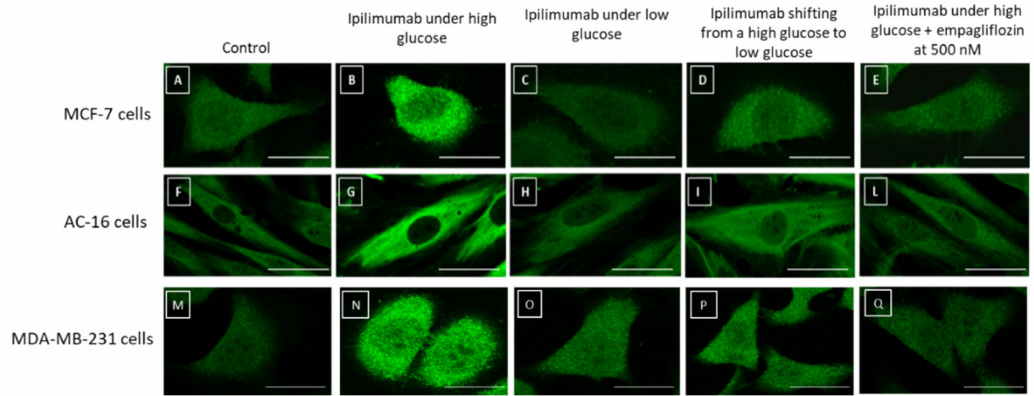
Figure 7. NLRP3 straining (green signals) in MCF-7 ( A – E ), AC-16 ( F – I , L ), and MDA-MB-231 cells ( M – Q ) treated with ipilimumab under high glucose ( B , G , N ); low glucose ( C , H , O ); shifting from a high glucose to low glucose ( D , I , P ), and high glucose + empagliflozin at 500 nM ( E , L , Q ). Untreated cells with an unrelated control IgG (control) were used as negative controls ( A , F , M ). Scale bar: 50 µ m. 2.8. Pro-Inflamamtory Cytokines and Growth Factors Are Overexpressed during Hyperglycemia NLRP3 and MyD88 are primary activators of cytokine storm in human cells in response to pro-inflammatory stimuli, as well as bacterial and viral infection [34]. We investigated cytokines and growth factors during exposure to ipilimumab under hyperglycemia, hypoglycemia, exposure to empagliflozin (under high glucose), and after shifting from high glucose to low glucose. E ff ectively, under hyperglycemia, compared to low glucose, MCF-7 cells exposed to ipilimumab (Figure 8A) overexpressed IL-1 β (245.5 ± 11.5 vs. 156.6 ± 3.4 pg / mg of protein, paired t -test p < 0.001, n = 3), IL-6 (173.3 ± 3.3 vs. 96.6 ± 6.7 pg / mg of protein, paired t -test p < 0.001, n = 3), PDGF (121.1 ± 8.3 vs. 72.3 ± 3.5 pg / mg of protein, paired t -test p < 0.001, n = 3), VEGF (182.5 ± 5.5 vs. 95.3 ± 3.8 pg / mg of protein, paired t -test p < 0.001, n = 3), and TGF- β (165.5 ± 8.5 vs. 97.7 ± 5.3 pg / mg of protein, (Figure 8B): under hyperglycemia, compared to low glucose, MDA-MB-231 cells exposed to ipilimumab overexpressed IL-1 β (321.1 ± 10.8 vs. 188.4 ± 7.6 pg / mg of protein, paired t -test p < 0.001, n = 3), IL-6 (256.6 ± 4.5 vs. 102.8 ± 7.2 pg / mg of protein, paired t -test p < 0.001, n = 3), PDGF (168.8 ± 8.9 vs. 78.9 ± 12.2 pg / mg of protein, paired t -test p < 0.001, n = 3), VEGF (234.4 ± 10.3 vs. 112.5 ± 11.2 pg / mg of protein, paired t -test p < 0.001, n = 3), and TGF- β (188.8 ± 5.6 vs. 121.1 ± 8.9 pg / mg of protein, paired t -test p < 0.001 n = 3). For both, shifting from high glucose to low glucose or being treated with empagliflozin under high glucose reduced significantly the expression of cytokines and growth factors compared with cells exposed to high glucose (Figure 8A,B). Instead, cardiomyocytes exposed to ipilimumab under high glucose (Figure 8C) overexpressed IL-1 β (154.4 ± 6.7 vs. 106.6 ± 5.8 pg / mg of protein, paired t -test p < 0.001, n = 3), IL-6 (112.2 ± 5.6 vs. 57.7 ± 6.7 pg / mg of protein, paired t -test p < 0.001, n = 3), PDGF (107.7 ± 7.2 vs. 62.1 ± 5.5 pg / mg of protein, paired t -test p < 0.001, n =